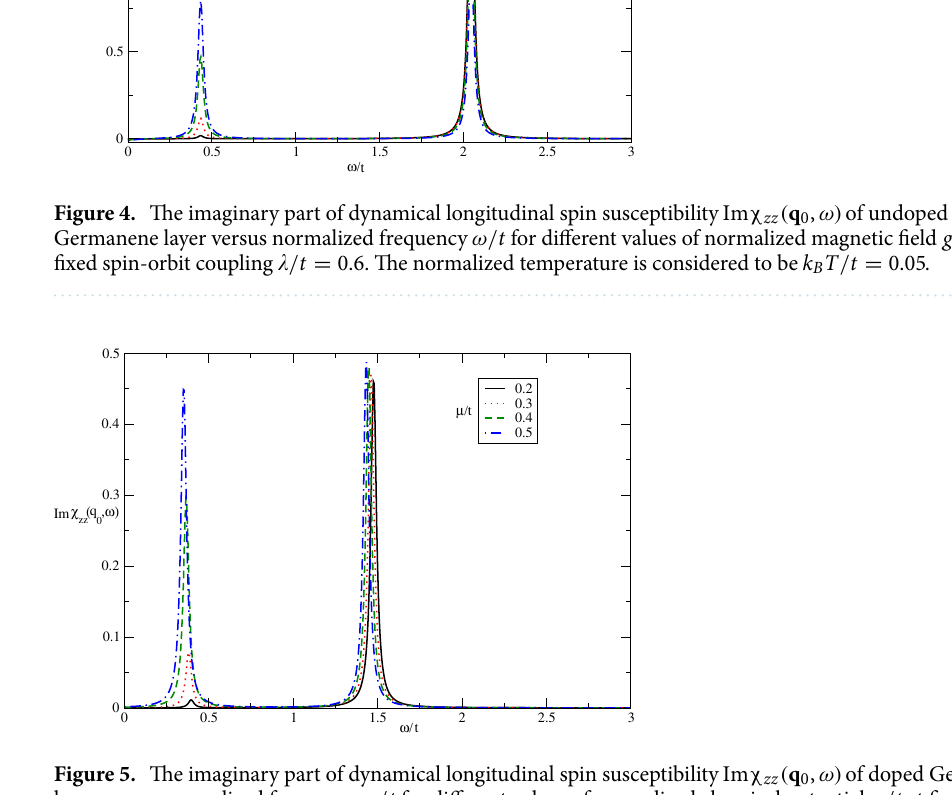
Figure 5. The imaginary part of dynamical longitudinal spin susceptibility Im χ zz ( q 0 , ω) of doped Germanene layer versus normalized frequency ω/ t for different values of normalized chemical potential µ/ t at fixed spin- 0.3 . The magnetic field is assumed to be zero. The normalized temperature is considered to orbit coupling (cid:31) / t = 0.05 be k B T / t =